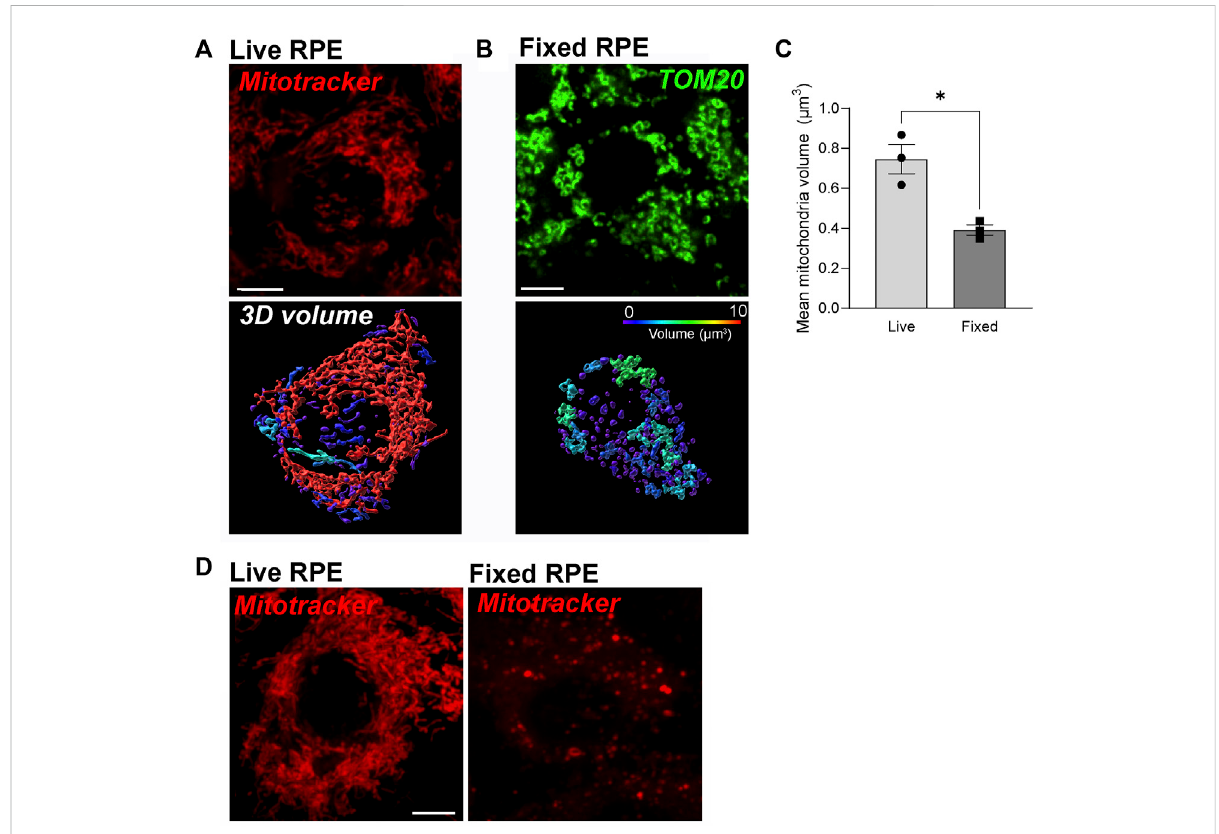
FIGURE 1 Dynamic RPE mitochondrial networks are best captured by high-speed live imaging and are destroyed by fi xation. (A) Stills from high-speed high-resolution live imaging of primary RPE monolayers labeled with Mitotracker deep red (red). (B) Immuno fl uorescence imaging of paraformaldehyde- fi xed primary RPE monolayers stained with an antibody to TOM20 (green). In A and B, top panel: single-plane view; Lower panel: 3D reconstructions. Warmer colors indicate larger volumes or integrated mitochondria, cooler colors indicate smaller volumes or fragmented mitochondria. (C) Quanti fi cation of mitochondrial volumes in A and (B) . Mean ± SEM. n = 3 independent experiments, ~170 cells per condition. * p = 0.0286 with Welch ’ s t-test. (D) Comparison of Mitotracker deep red (red) fl uorescence before and after fi